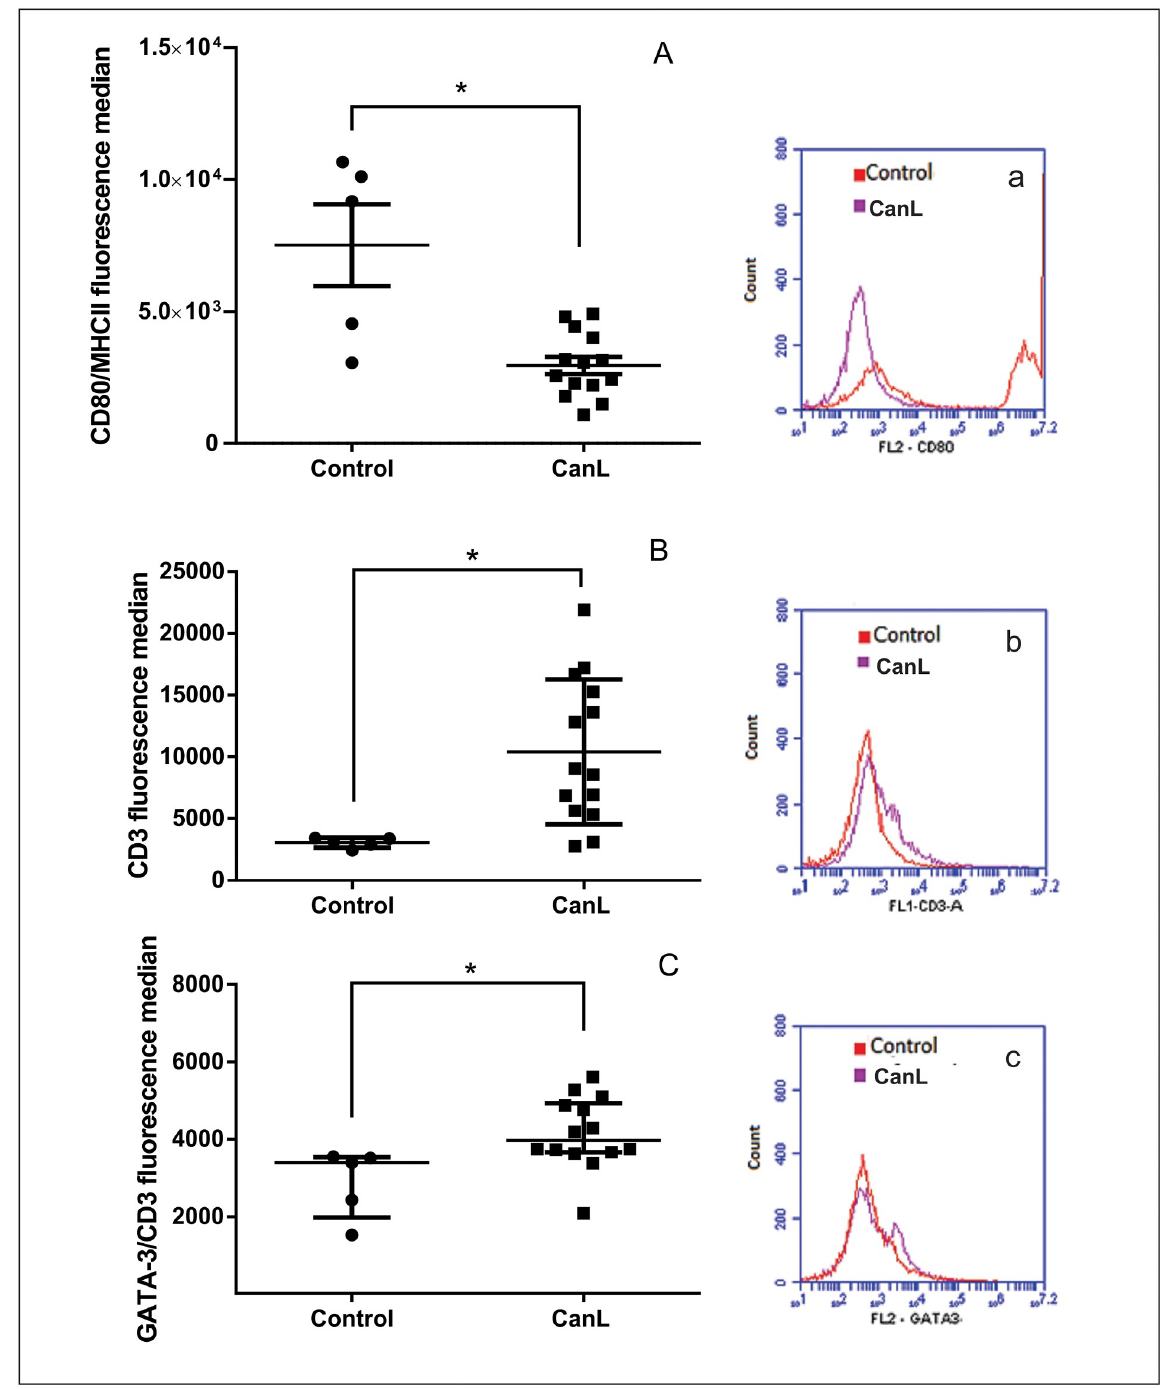
Fig 2. Expression of CD80/MHCII, CD3 and GATA-3/CD3 in SL culture. Expression of CD80 in MHCII + (CD80/MHCII) leukocytes (A), CD3 (B) and GATA-3 in TCD3 + leukocytes (GATA-3/CD3) (C). Splenic leukocytes from control (healthy dogs) and CanL (dogs naturally infected by L . infantum) groups, were maintained in culture for 48 h at 37˚C and 5% CO 2 without any treatment and, posteriorly, were marked with monoclonal antibodies conjugated to fluorochromes for analyze by flow cytometry. Bars represent expression median values of CD80/ MHCII (9177 and 2818), CD3 (3144 and 8816) and GATA-3/CD3 (3397 and 3971), 25 th percentile interquartile range of CD80/MHCII (3802 and 2103), CD3 (2684 and 5565) and GATA-3/CD3 (1979 and 3661) and 75 th percentile interquartile range of CD80/MHCII (10,389 and 4,109), CD3 (3406 and 15616) and GATA-3/CD3 (3533 and 4931) from control and CanL groups, respectively. Symbols represent data from individual animals. Asterisks represent significant differences (Mann-Whitney test, p = 0.01 (A), p = 0.007 (B), p = 0.007 (C)). Representative histogram of overlay protein expression analysis showed significant differences: CD80/MHC (a), CD3 (b), and GATA-3/CD3 (c) between control (red) and infected (purple) groups. https://doi.org/10.1371/journal.pntd.0011039.g002 PLOS NeglectedTropical Diseases | https://doi.org/10.1371/journal.pntd.0011039 January 31,